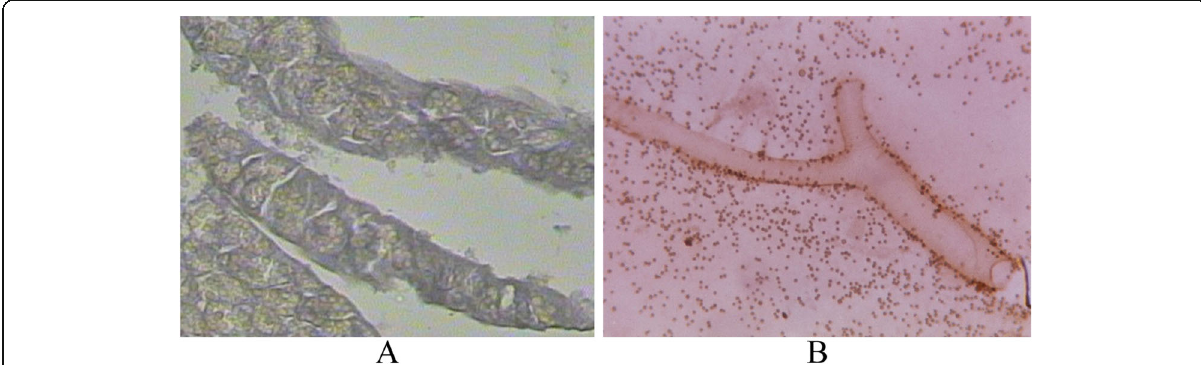
Fig. 3 Cross sections in Galleria mellonella larvae. a Six days post-infection with Gm MNPV showing PIBs in nuclei of salivary gland epithelial cells. b Smear of body fluid from G. mellonella larva at 7th day post-treatment showing complete disintegration of body cells except the chitinous tenidium of the